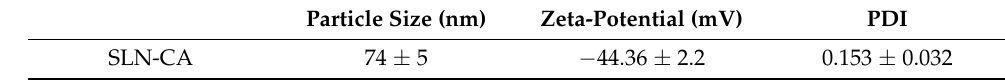
Table 1. Results of particle size, zeta potential, and polydispersity coefficient.